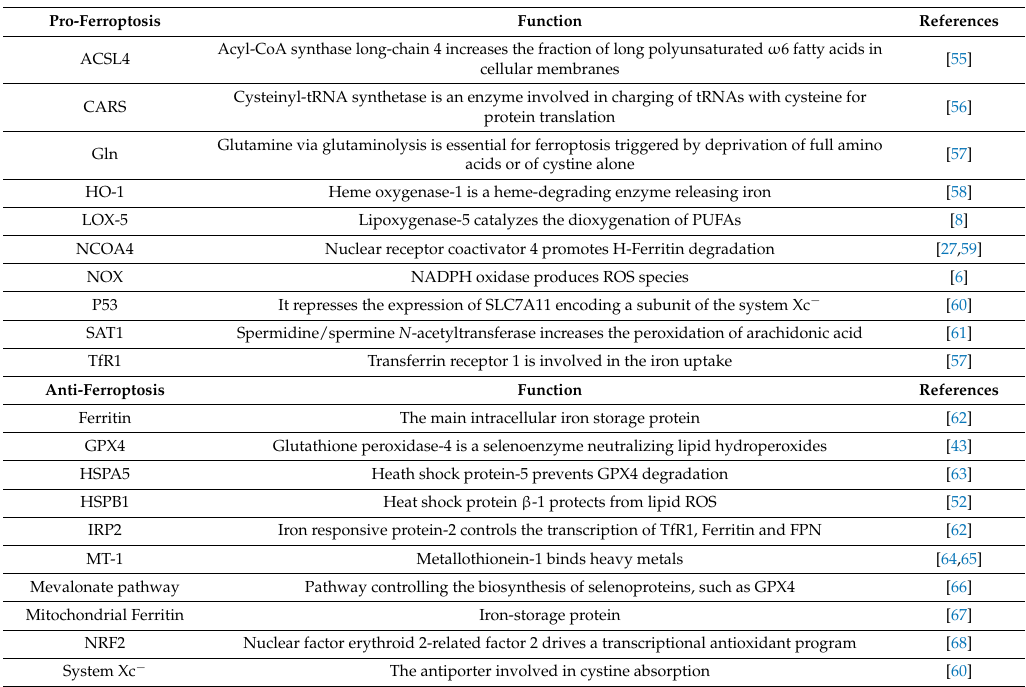
Table 1. Proteins and pathways modulating ferroptosis.